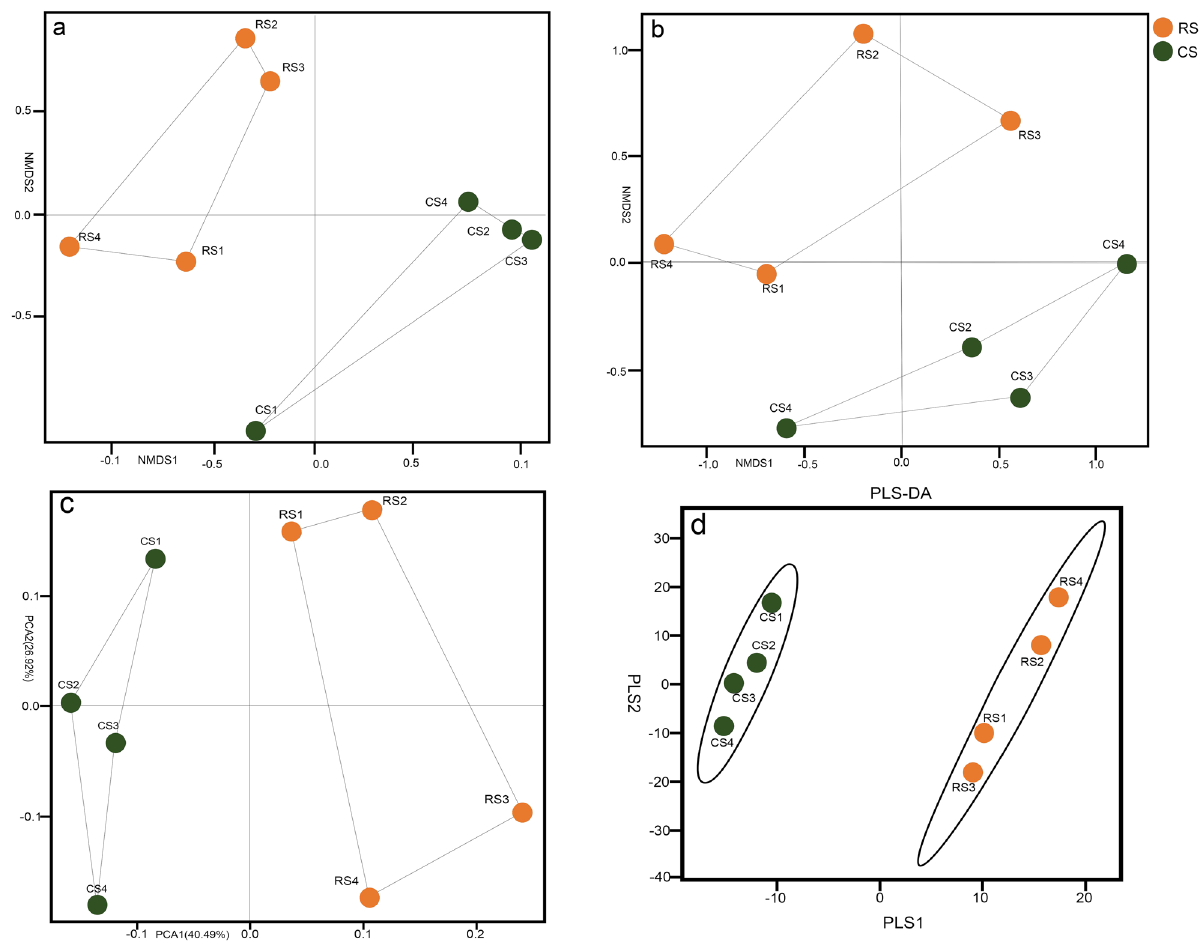
Figure 3. Nonmetric multidimensional scaling (NMDS) ordination plot of bacterial community structure comparing 10-year post-ginseng rotation soil (RS) and soil in which no ginseng was grown (CS) before ginseng planting. ( a ) unweighted and ( b ) weighted UniFrac distance matrix. ( c ) PCA (principal component analysis) of bacterial community structure. ( d ) PLS-DA (partial least squares discriminant analysis) of bacterial community structure. The shorter the distance between two points, the higher the similarity of the microbial community structure between the two